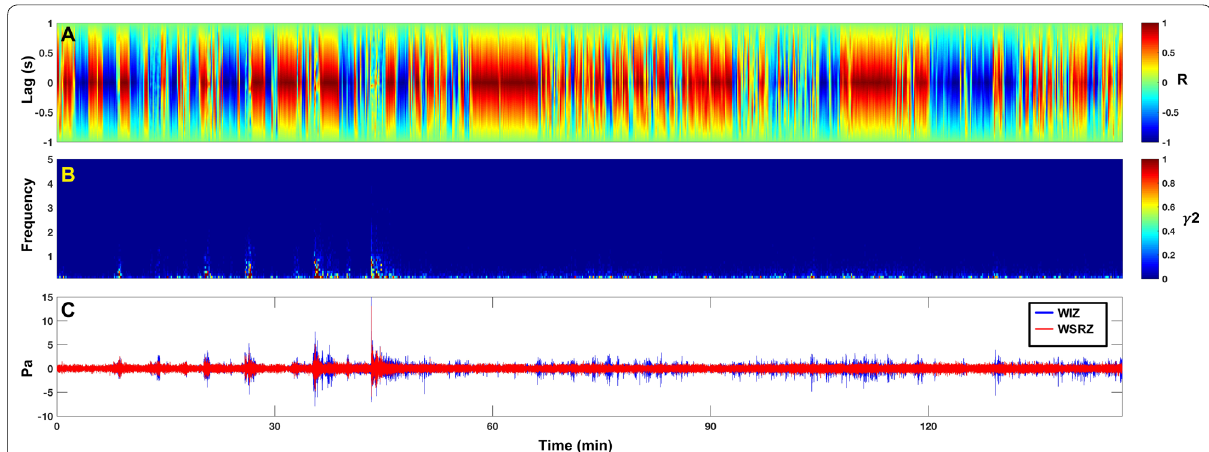
Fig. 9 Acoustic time evolution comparing station WIZ with WSRZ of the 27 April 2016 eruption. A Unfiltered cross-correlation, B unfiltered coherence, C acoustic signals WIZ and WSRZ overlain filtered between 0.5 and 10 Hz. Subfigures A and B were estimated from 10-s moving time